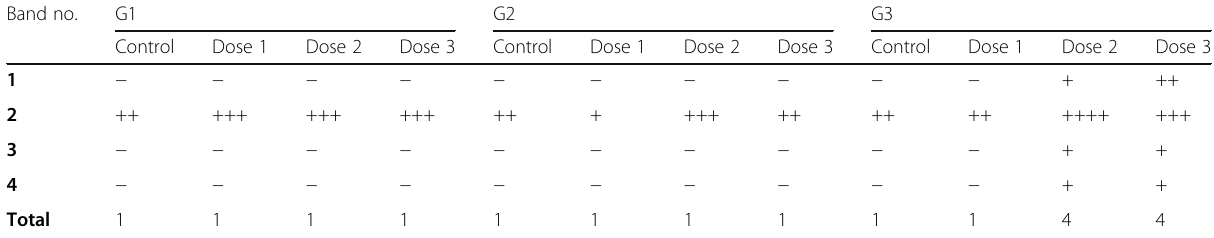
Table 9 Effects of different ethyl methane sulfonate (EMS) doses on peroxidase (POX) isozymes of lentil cultivars Band no.